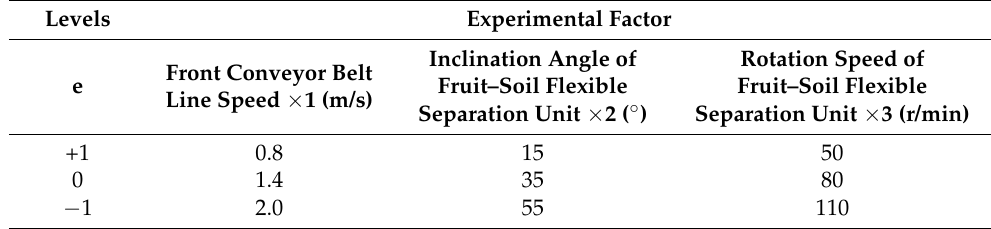
Table 2. Experimental factors’ codes.